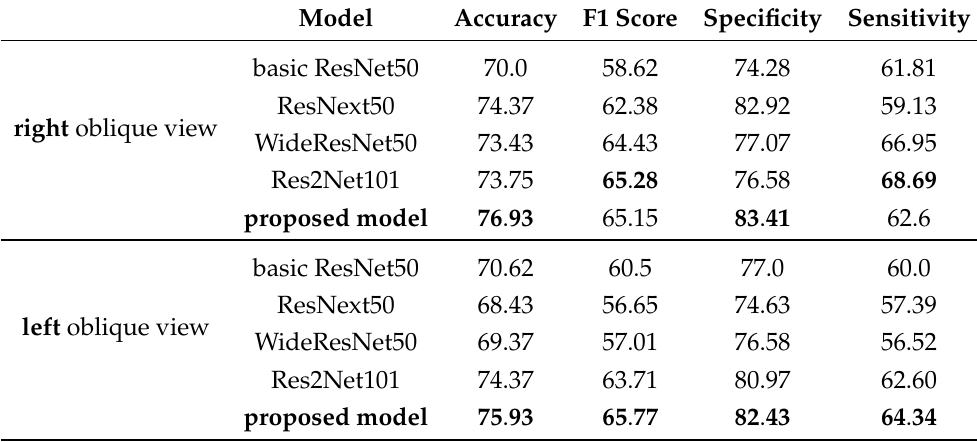
Table 6. Comparison of the result values of the ResNet50 model that applied all the methods, i.e., fine- tuning, ROI cropping, HE, Flip, and STN, proposed in this study (proposed model), three latest ResNet models (ResNext50, WideResNet50, Res2Net101) that applied all the proposed methods, and no method applied ResNet50 model (basic